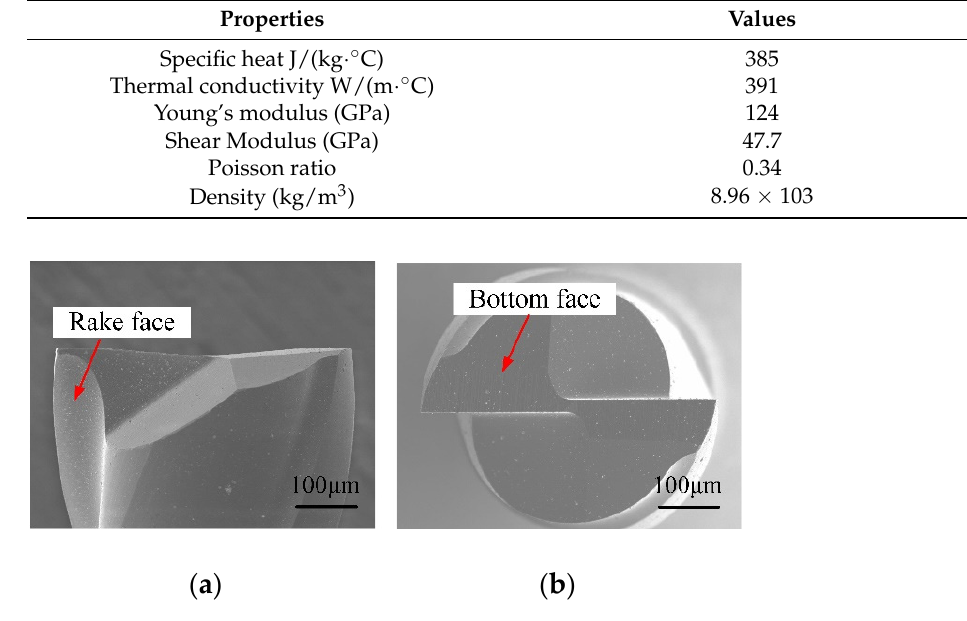
Table 2. Physical properties of OFC-TU1 material. Figure 5. Schematic illustration of the machine device.